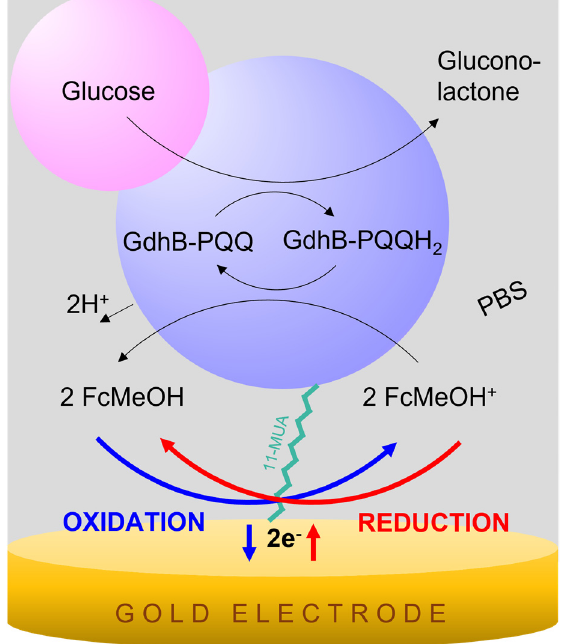
Figure 3. PQQ-GdhB biosensor reaction scheme for glucose detection in the presence of redox mediator FcMeOH + /FcMeOH in PBS electrolyte solution. Electrons pass indirectly from glucose and PQQ-GdhB to the electrode via mediator. Mediator oxidation is marked in blue and reduction in red.